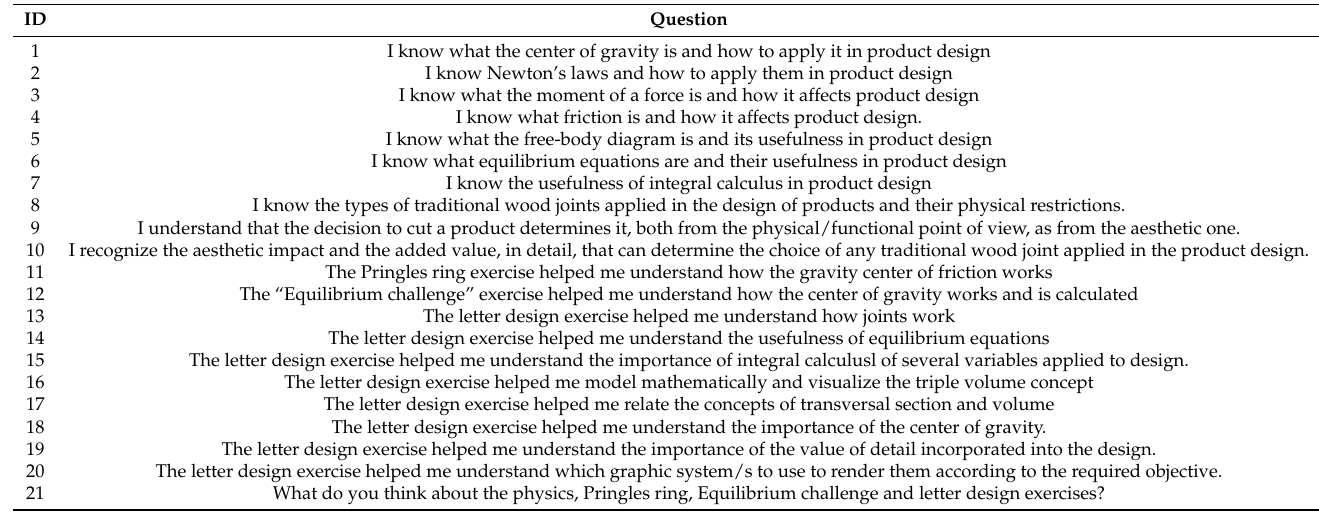
Table 3. Questions asked in the students’